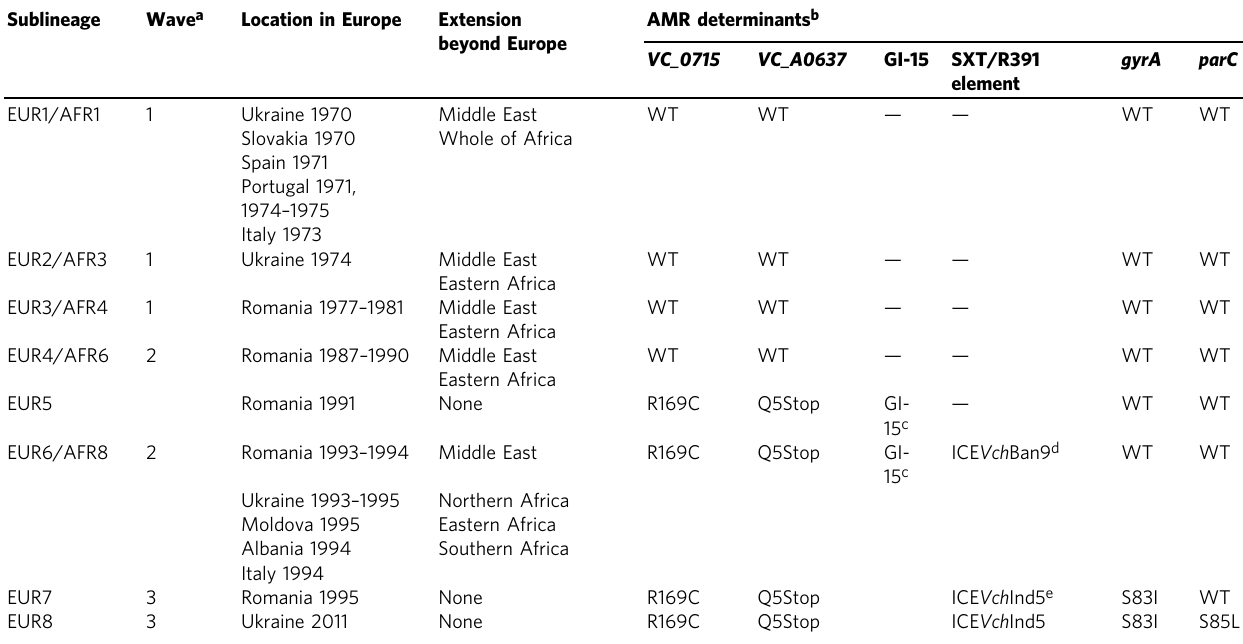
Table 3 Characteristics of the Vibrio cholerae O1 El Tor sublineages introduced into Europe, 1970 – 2011.